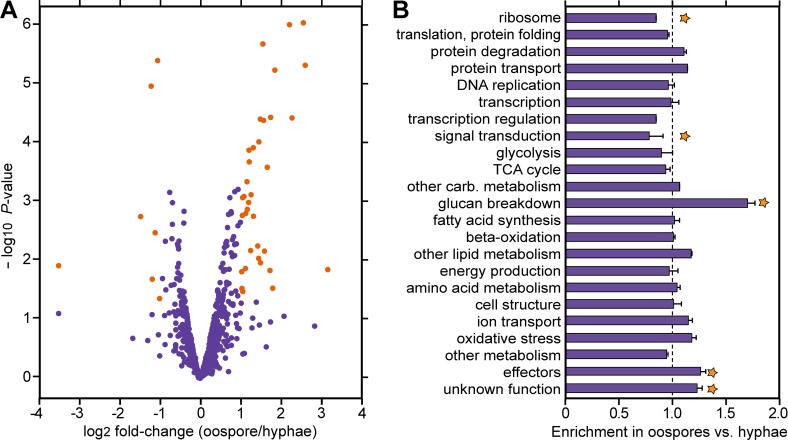
Analysis of proteins in oospores and vegetative hyphae.(A) Ratio of protein levels in oospores compared to hyphae based on iTraq analysis. Orange spots correspond to those that show >2-fold changes (log2 of 1) at P<0.05. (B) Enrichment of proteins in different functional classes. Values were determined by summing the median-normalized pseudospectral counts of all proteins in each functional class, and dividing the value for oospores by the sum from vegetative hyphae. Stars represent differences significant at p<0.05 based on Bayesian estimation, with error bars reflecting the biological replicates. Proteins in each category are shown in S6 Table.